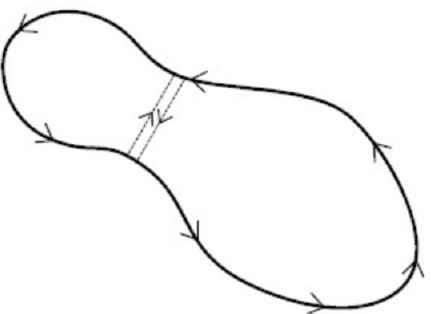
Figure 32 . The (cid:12)gure shows how we need to require the orientations. The cyclic chain in the Minkowski space time. There should be considered: (a) There are negative and compensating parts indicated by dotted line. These parts are pair of compensating pieces. (b) The cyclic chain with positive parts denoted by solid line with positive